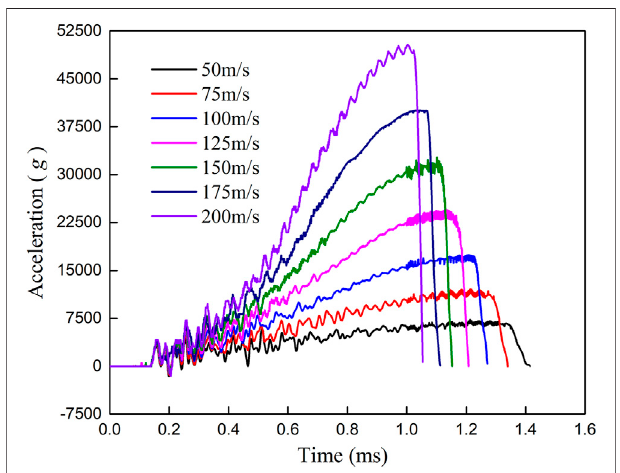
FIGURE5| Comparisonofimpactloadwaveformsatdifferentvelocities.